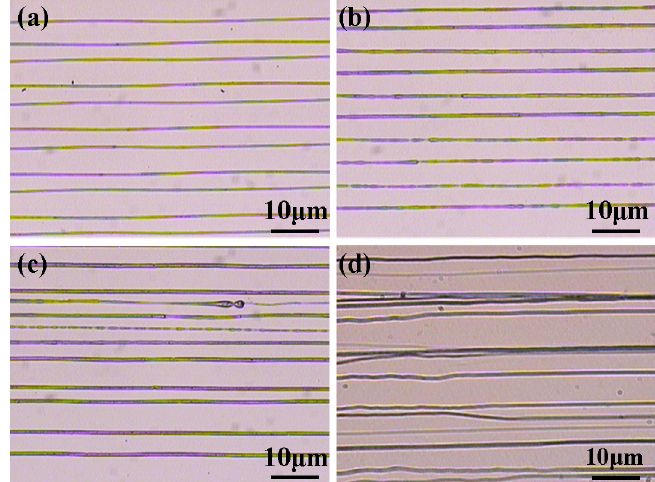
Figure 5. The direct-written patterns under different applied voltages: ( a ) 3.3 kV; ( b ) 3.6 kV; ( c ) 3.9 kV; and, ( d ) 4.2 kV. The distance between spinneret and collector, the collector moving speed, the solution concentration and the solution supply rate were 6 mm, 100 mm/s, 10%, and 100 μL/h, respectively.